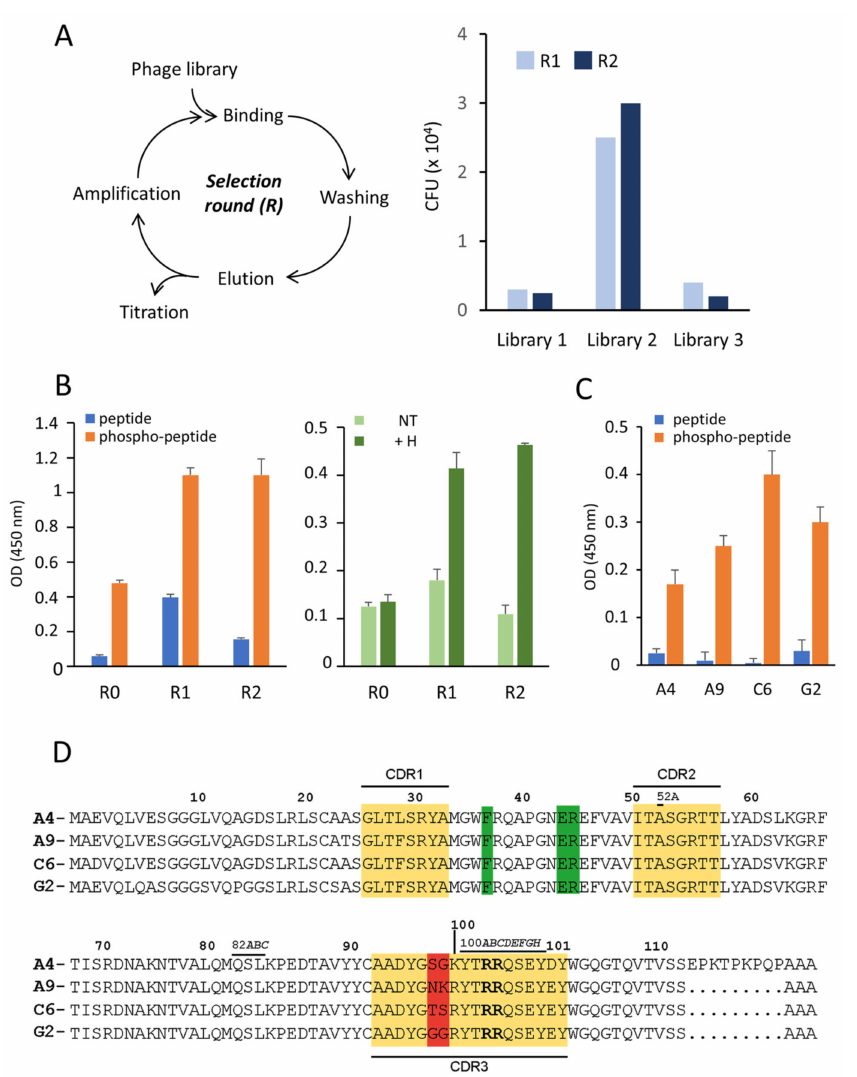
Figure 1. Development and selection of specific anti- γ -H2AX nanobodies. ( A ) Schematic represen- tation of a phage display selection round (left). The histogram on the right shows the number of phages retained on plate after two rounds of selection with three different libraries issued from PBMCs of individual animals. CFU, colony-forming units. ( B ) The specific binding capacity of the phages selected from the library 2 were assayed by phage-ELISA with either peptides as indicated (left) or histones extracted from H-treated or untreated (NT) cells (right), both immobilized on plate. ( C ) Four individual VHH-phages identified by sequencing (A4, A9, C6, and G2) were subjected to phage-ELISA. Their specific binding to either the non-phosphorylated (peptide) or the phosphory- lated (phosphopeptide) H2AX C-terminal peptide is shown. Bound phages were revealed with an HRP-labelled anti-M13 conjugate (Materials and Methods). ( D ) The sequences of clones A4, A9, C6, and G2 are aligned based on homology, according to the Kabat numbering system [27]. The residues highlighted in yellow correspond to the CDR residues. Residues 114 to 125 are part of the hinge region. The R residues at positions 100C and 100D are shown in bold and the residues highlighted in green are hallmark residues of the VHH variable domain